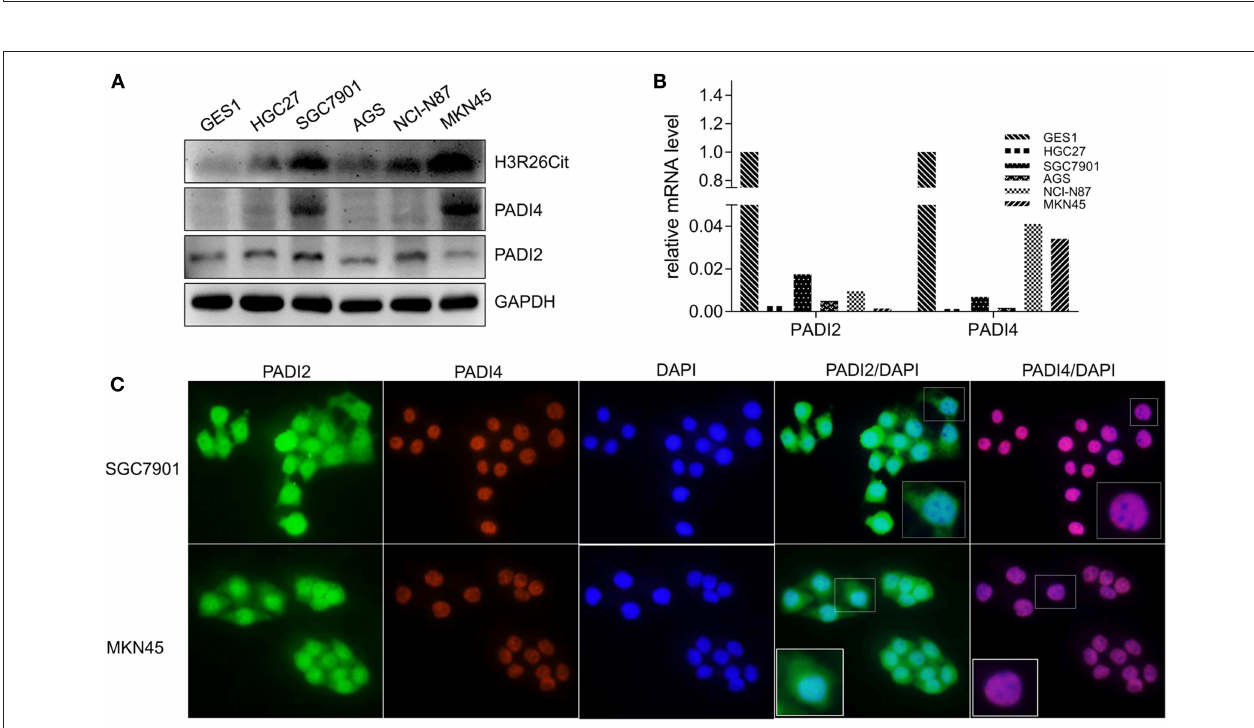
FIGURE 2 | Analysis of basal expression of H3R26Cit and its catalytic enzymes PADIs. (A) The protein expression of H3R26Cit, PADI2, and PADI4 in GES-1 gastric mucosa cells and several gastric cancer cell lines. (B) The expression of PADI2 and PADI4 mRNA in GES-1 gastric mucosa cells and several gastric cancer cell lines. (C) Subcellular localization of PADI2 and PADI4 proteins in SGC7901 and MKN45 gastric cancer cell lines.